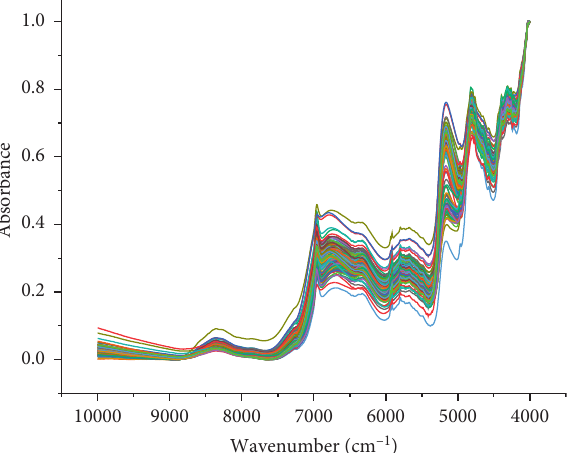
Figure 1: Raw NIR spectra of 99 ASR samples.